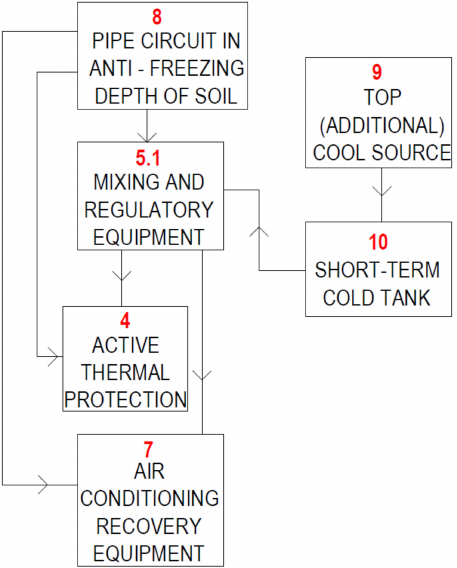
Figure 11. Functional wiring diagram of a combined building-energy system in cooling and/or ventilation mode [17].